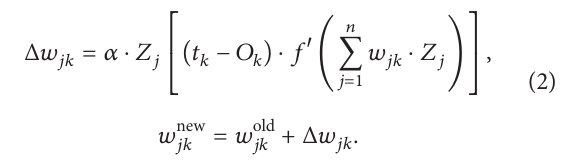
layer; however, multiple hidden layers may be added as well. The final layer of nodes is the output set, representing the output of the entire